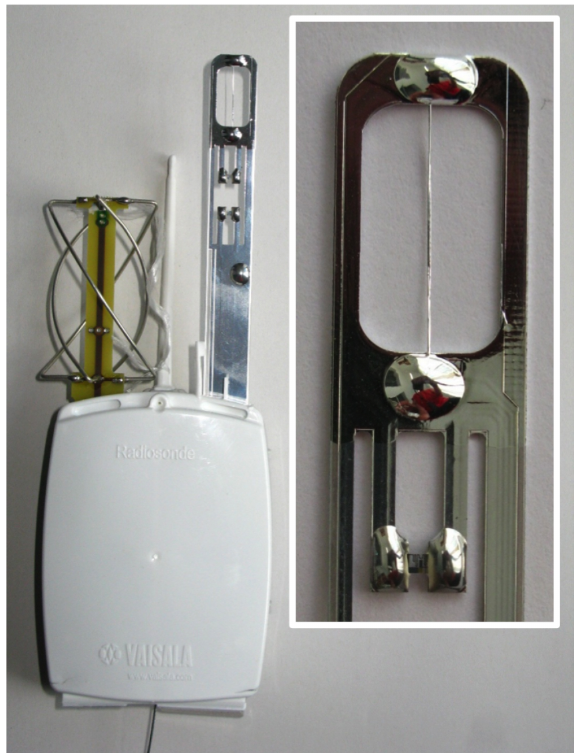
Figure 1. Photograph of the RS92 radiosonde showing the GPS an- tenna on the left and the sensor boom on the right. The inset shows the magnified tip of the sensor boom with the wire-shaped temper- ature sensor and one of the humidity